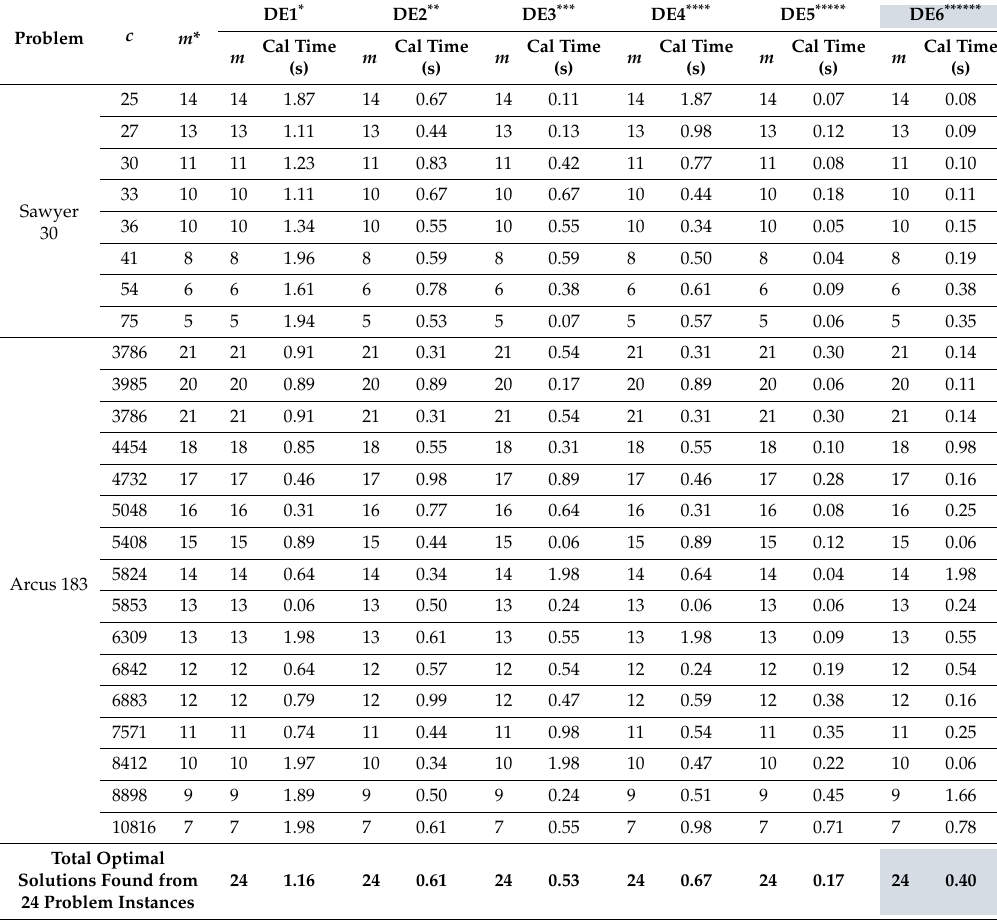
Table 5. The results of the experiment on the UALBP-1 by using the basic DE algorithm and improved DE algorithm with the Sawyer and Arcus 1